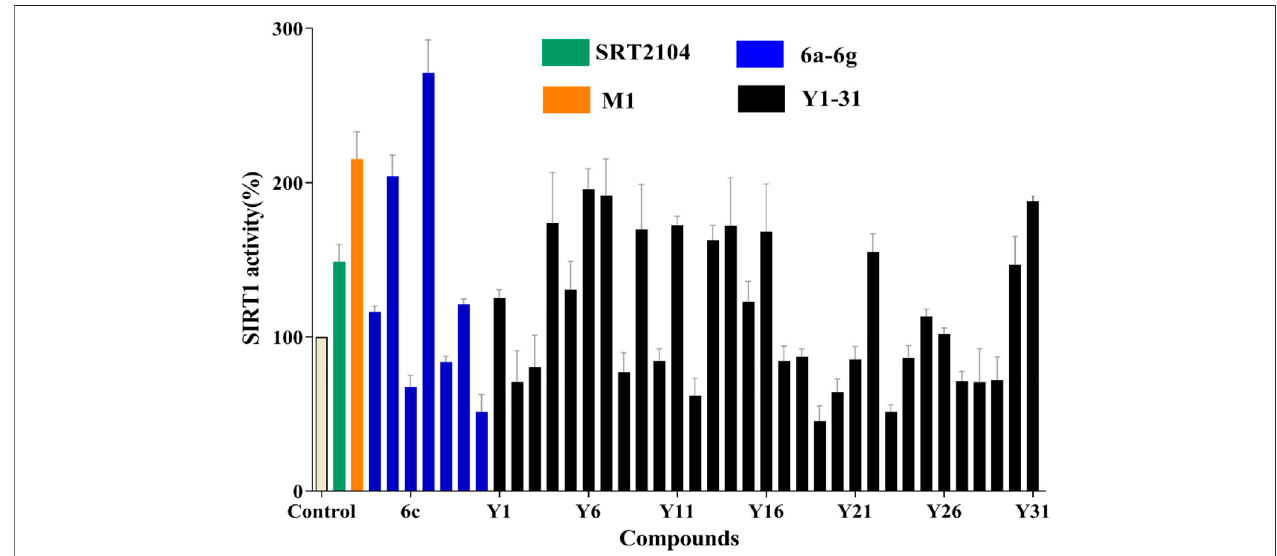
FIGURE 3 | SIRT1 deacetylation activities of lead compound M1 and its analogues Y1-31 and 6a-g at the concentration of 10 μ M, with one black control and one positive control SRT2104 (10 μ M).